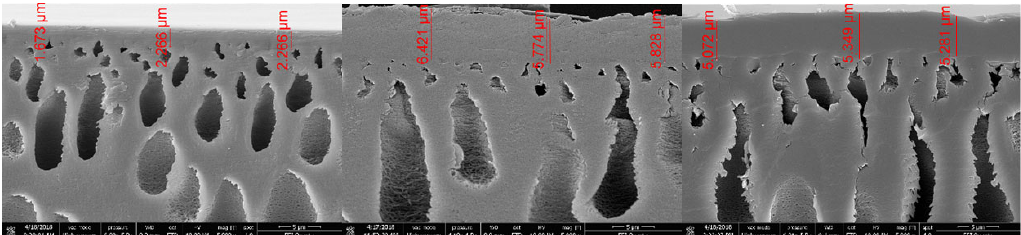
Figure 9. SEM measurements of a new membrane ( left ), a pre-conditioned membrane ( middle ), and a used membrane at 40 °C and 25 bar ( right ). The shown values represent the active membrane layer thickness.